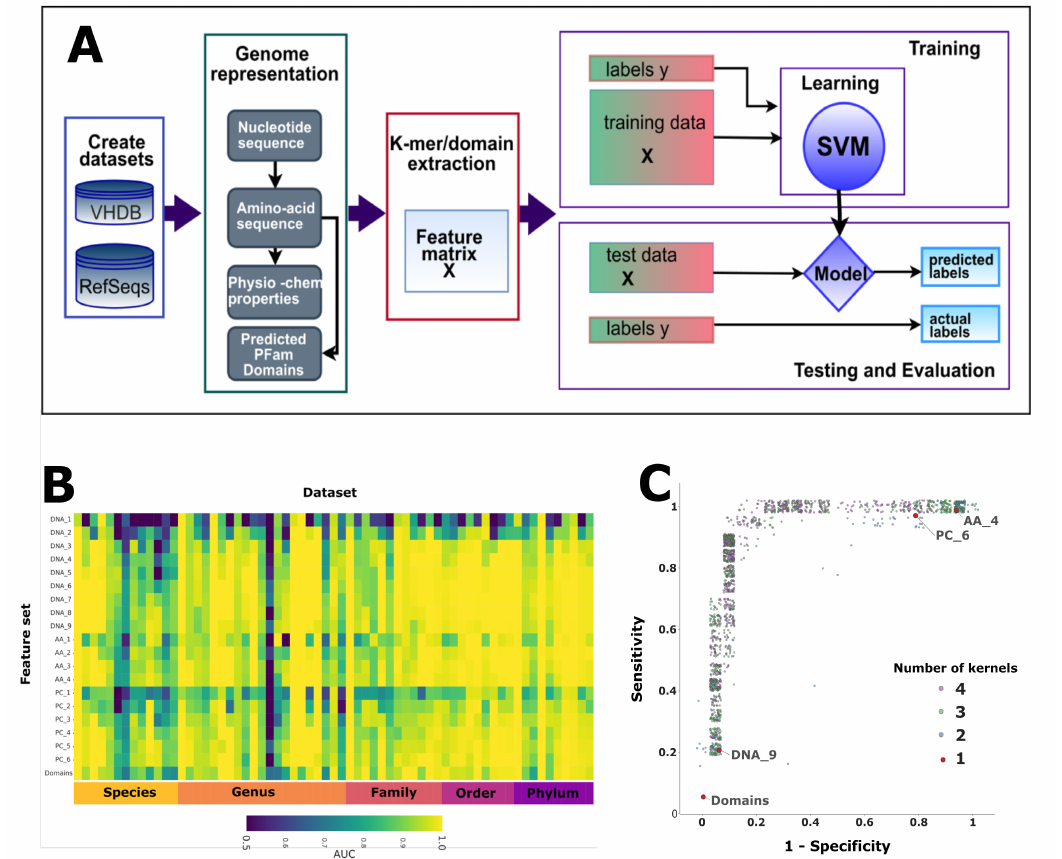
Figure 7. ( A ) Workflow for extracting and testing different level feature sets for predicting host taxon information. ( B ) Comparison of the results (AUC) for all the bacteria datasets for all the feature sets. ( C ) A plot of sensitivity versus specificity for kernel combination applied to one dataset. Each point represents the results for a classifier, each with a different combination of kernel weights, with the number of kernels contributing shown by the point